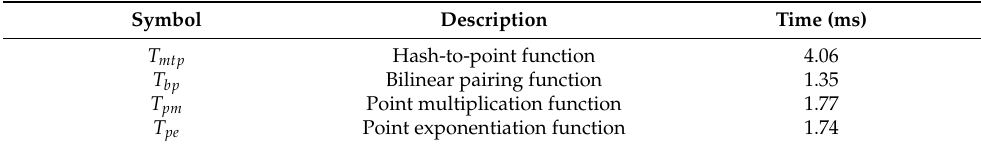
Table 3. The execution time of pairing and element